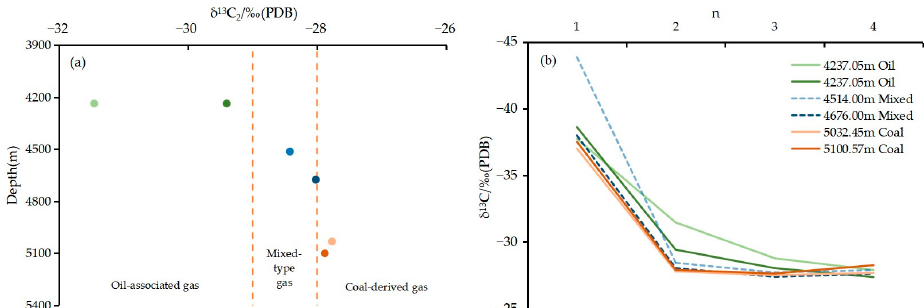
Figure 9. Relationship of δ 13 C 2 vs. depth ( a ) and carbon isotopic compositions of alkanes ( b ) of the natural gases from well pen 4 in the Mosuowan Bulge, Junggar Basin (data from ref. [56]). The δ 13 C 1 - δ 13 C 2 and Ln(C 1 /C 2 ) of the gases from the Sangonghe formation of the Shixi